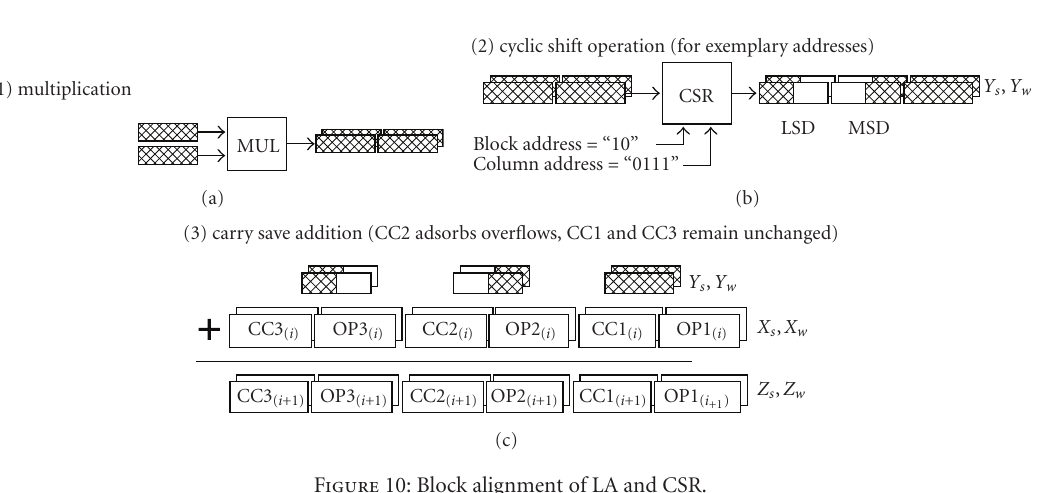
Figure 9: Accurate scalar product unit.